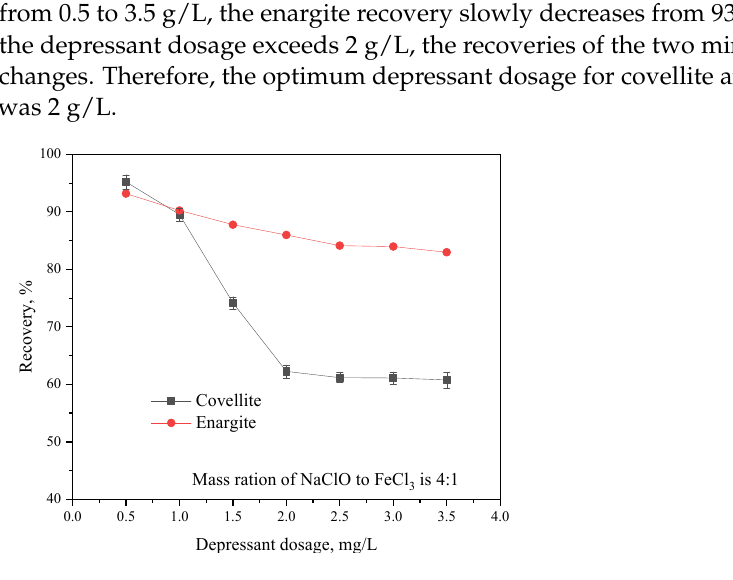
Figure 4. Separation efficiency as a function of the mass ratios of NaClO to FeCl 3 at Ph = 10.